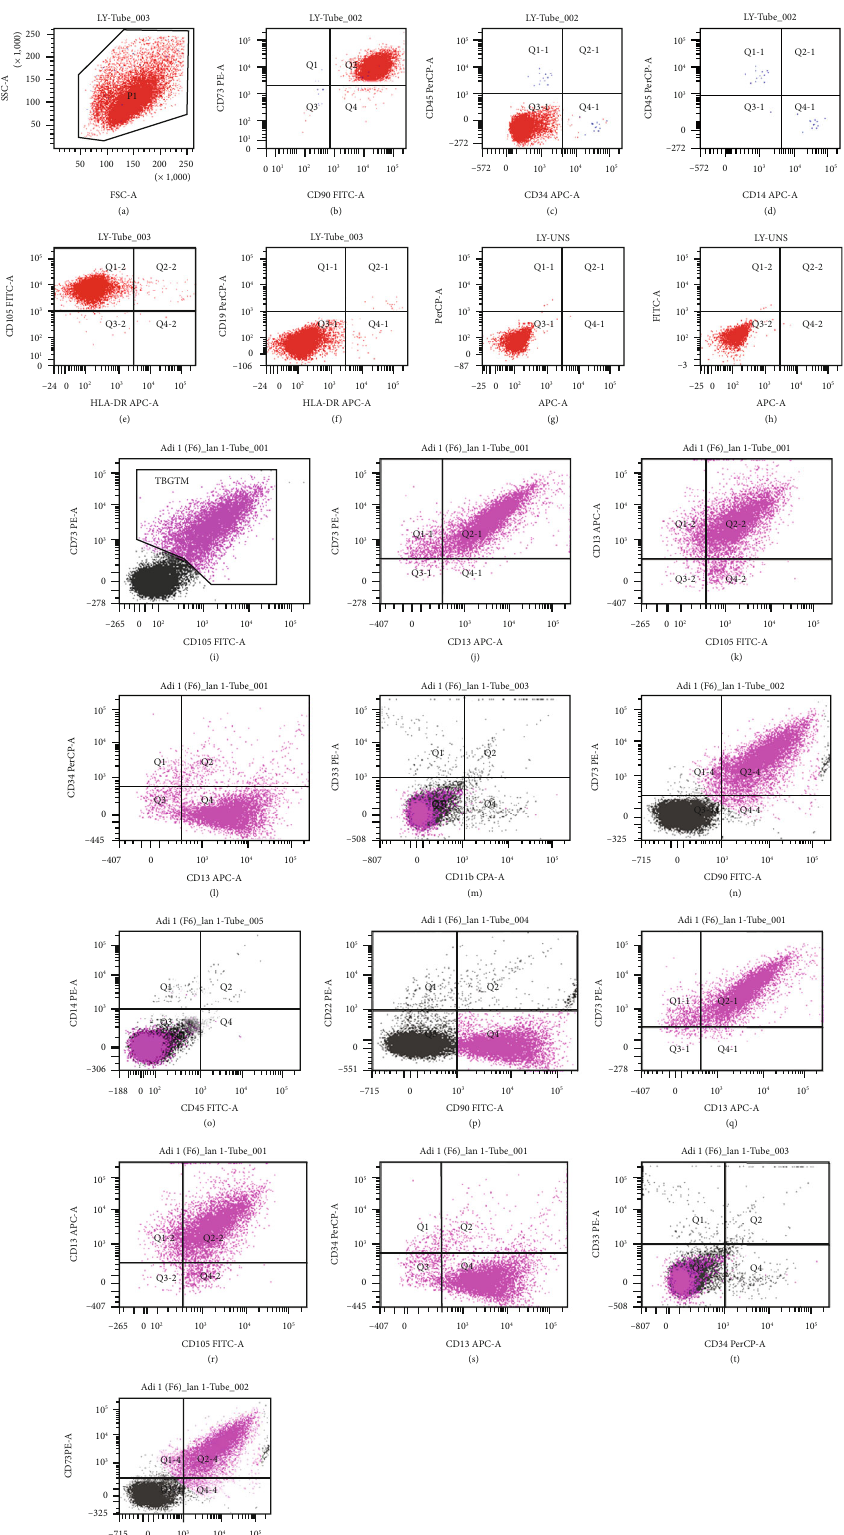
Figure 2: Flow cytometry results con fi rmed the presence of MSC markers (a – u) CD13 + CD73 + CD90 + CD105 + and SSC low and a negative expression for CD 11b, CD14, CD19, CD34, CD45, and